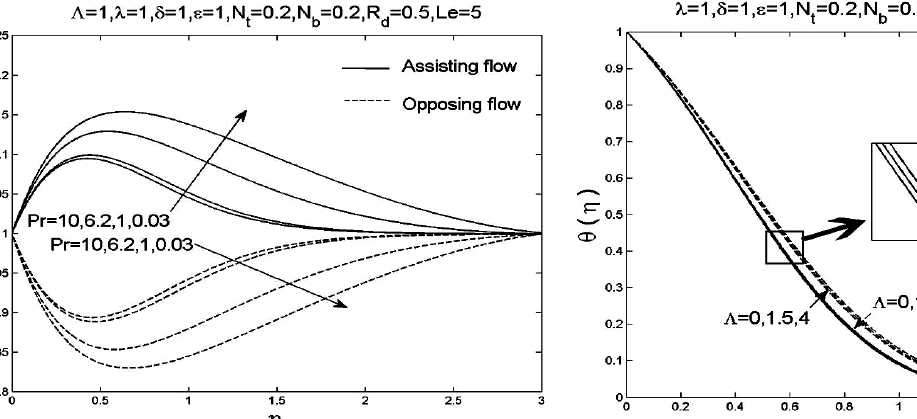
Fig. 9. The effect of the Prandtl number Pr on the velocity pro- files ( ) f η′ .